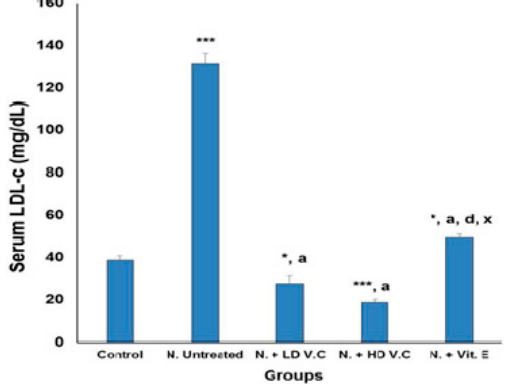
Figure 4. Effect of V. calvoana extract on serum low density lipoprotein cholesterol (LDL-c) in paracetamol treated rats. Values are presented as mean ± SEM, n = 5. * p <0.05, *** p <0.001 vs. control, a = p <0.001 vs. N. untreated, d = p <0.001 vs N. + LD V.C., x = p <0.001 vs N. + HD V.C. Where N = hepatotoxic.